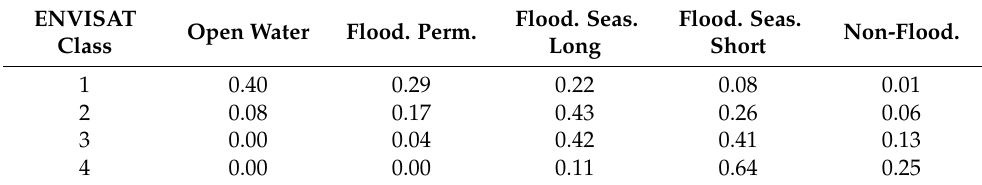
Table A2. Confusion matrix between 4 classes of RA backscattering coefficients from ENVISAT and the 5 land type classes identified on the study sites.